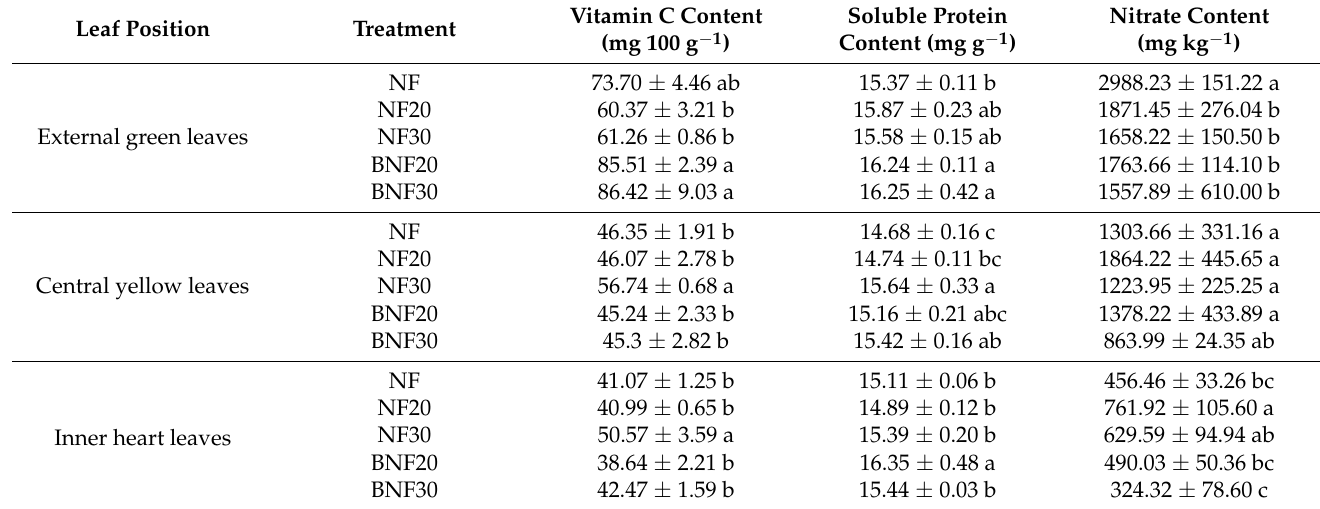
Table 3. Effects of different fertilization treatments on the quality of leaves in different positions of ‘yellow roses’ cabbage at harvesting stage. Leaf